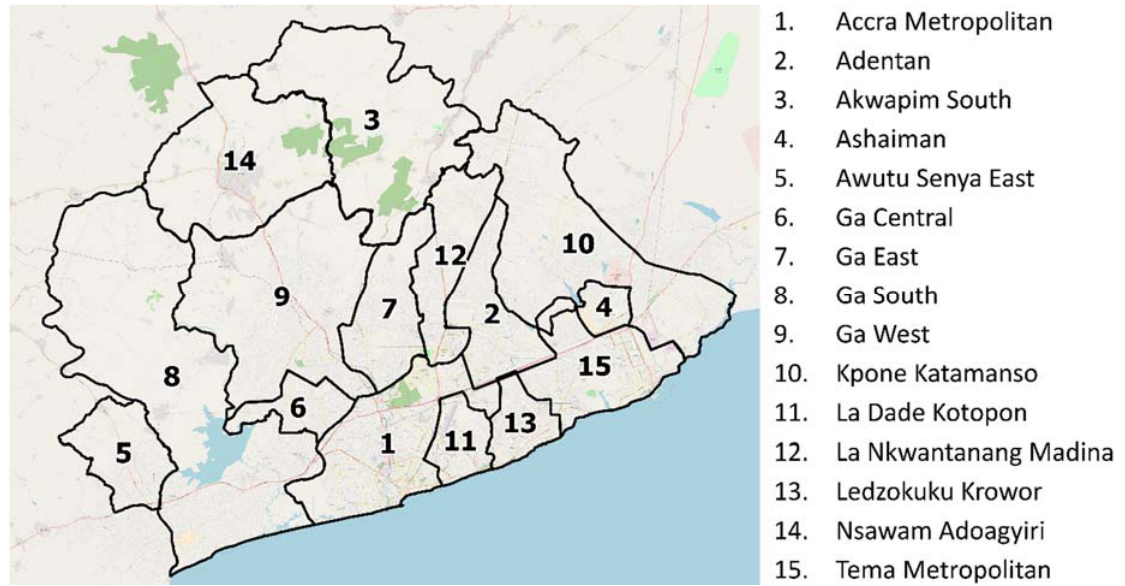
Figure 2. Boundaries of Greater Accra Metropolitan Area (GAMA) administrative regions from 2012 onwards.